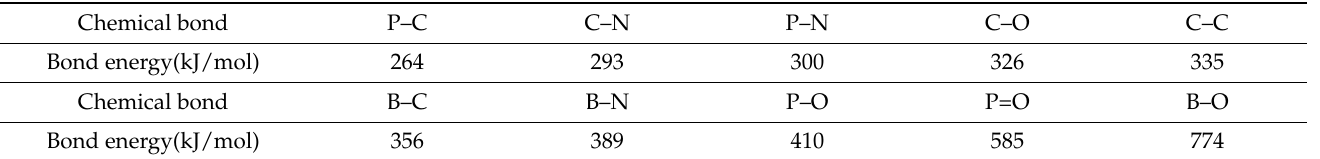
Table 5. Relevant chemical bonding energies in